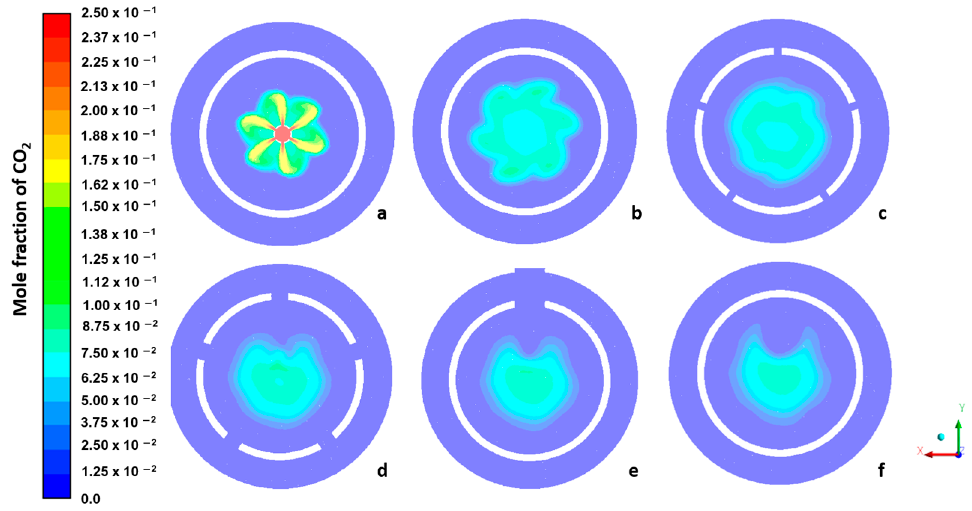
Figure 12. Mole fraction profiles of CO 2 for cross-sectional planes: ( a ) plane 1; ( b ) plane 2; ( c ) plane 3; ( d ) plane 4; ( e ) plane 5; ( f ) plane 6.